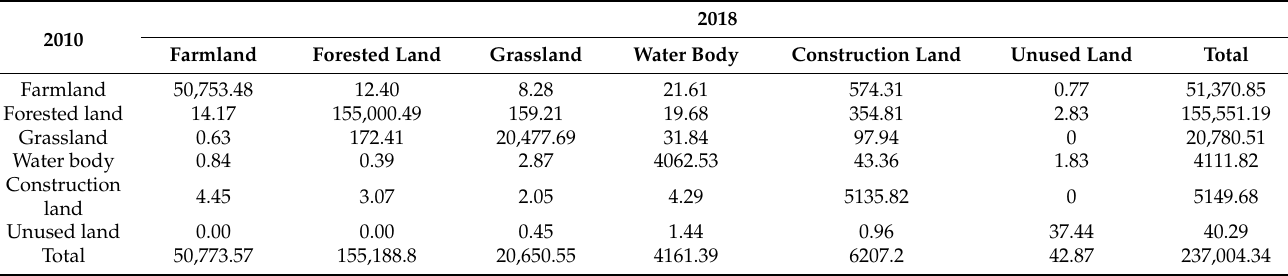
Table 3. Land use change matrix of Guangxi during 2010–2018